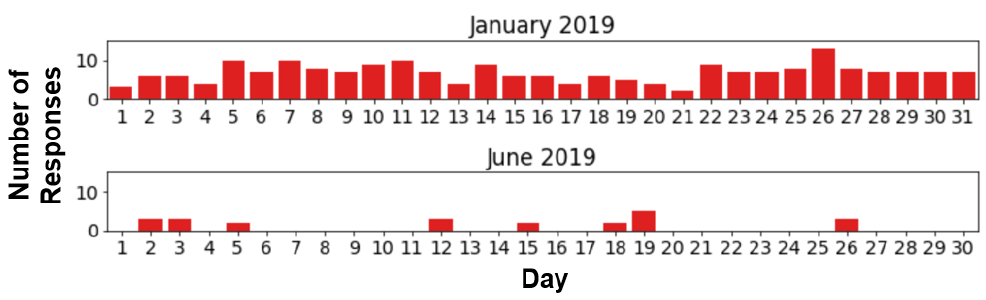
Figure 12. Number of responses made by station BIBBRAGA2 for January and June